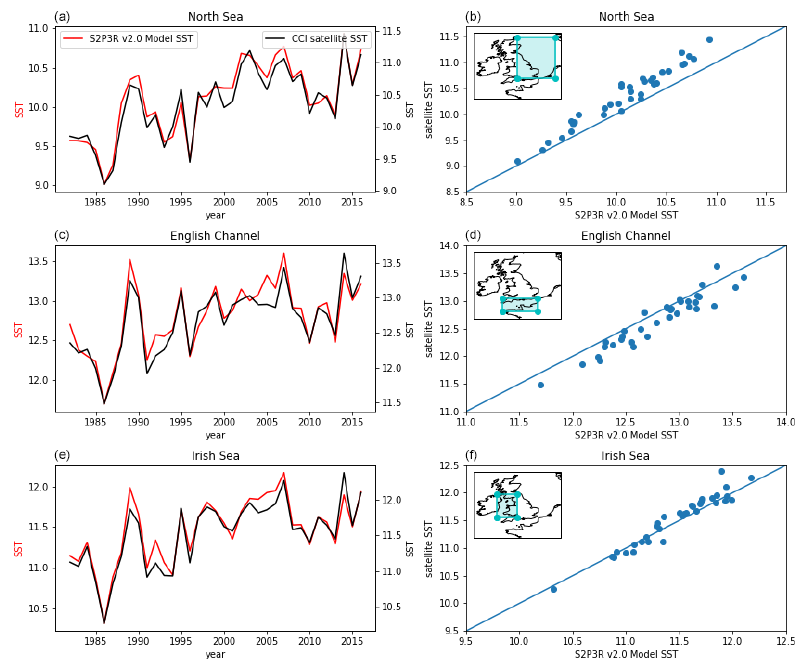
Figure 11. S2P3R v2.0 SST averaged annually and across the three regions highlighted in inset maps and annually averaged satellite SSTs (Merchant et al., 2019) from the same regions.